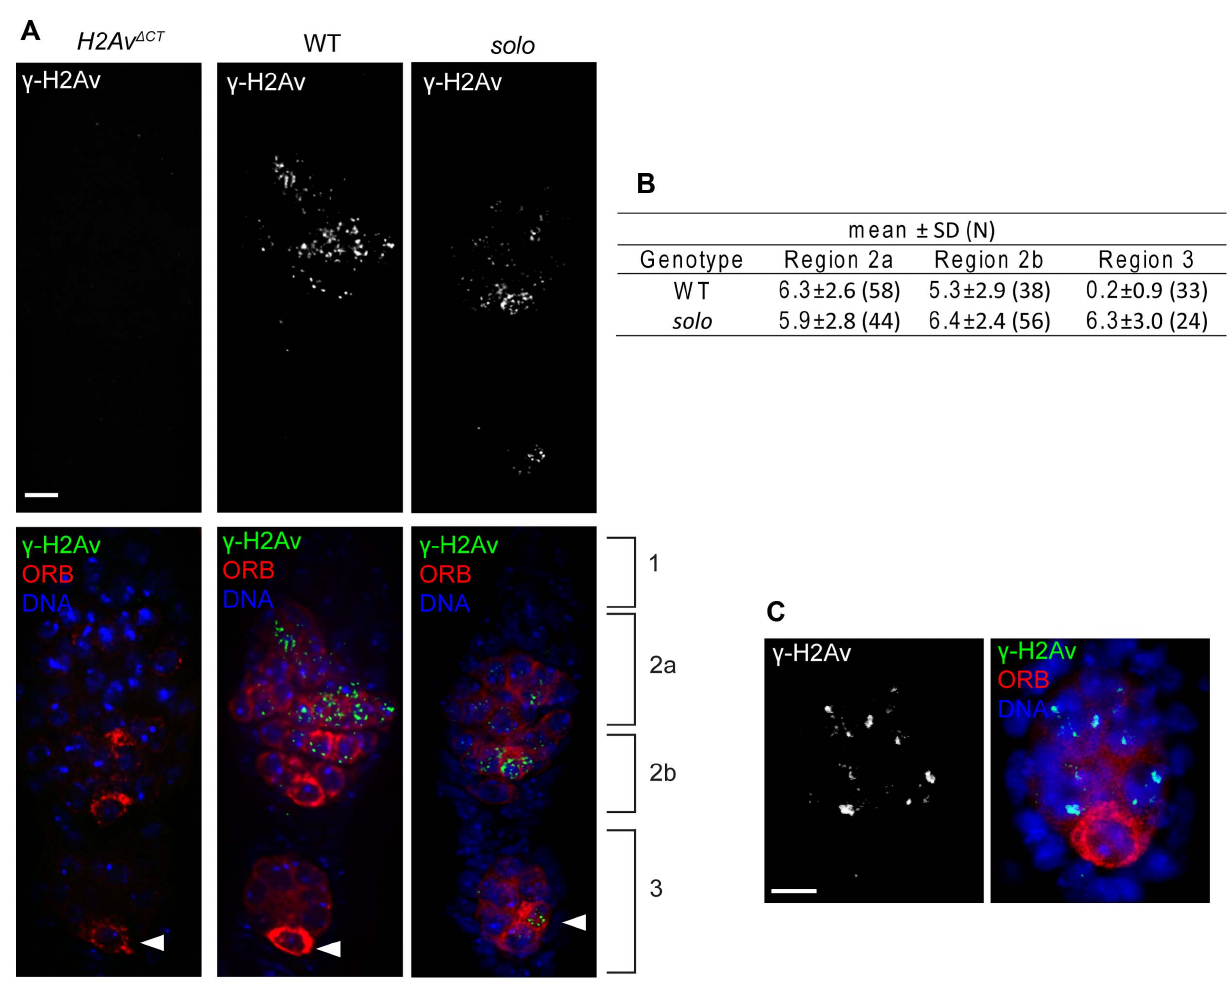
Figure 6. solo mutations cause a transient delay in DSB repair. Pro-oocytes and oocytes from solo mutant ( solo Z2-3534 / Df(2L)A267 ) and WT females were identified and staged by ORB staining and relative positions within germarium. c -H2Av was stained by anti- c -H2Av antibody and DNA was visualized with DAPI. c -H2Av foci from pro-nurse cells were not scored. Scale bars: 5 m m. (A) c -H2Av staining in germaria. Left panel shows absence of antibody staining in P{w + H2Av D CTXC }; l(3)H2Av 810 females in which the only expressed histone H2Av subunits are deficient for serine-137 and are not phosphorylated in response to DSBs [66]. Center and right panels show antibody staining in WT and solo germaria. c -H2Av staining is absent in region 3 oocyte in WT but present in region 3 oocyte in solo (arrowheads). (B) Average number of c -H2Av foci per nucleus in pro-oocytes and oocytes at different stages. N is the number of nuclei scored. (C) Absence of c -H2Av staining in the oocyte nucleus of a stage 2 solo egg chamber. Egg chamber was from the same solo ovariole from which the germarium shown in panel A was